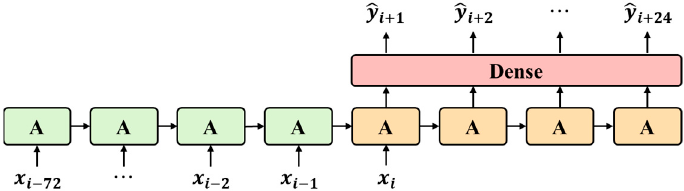
Figure 12. Multi-step architecture of LSTM and GRU models using the multi-output strategy. Table 3. Hyperparameters in the Han, Geum, Nakdong, and Seomjin River datasets. Model Configuration